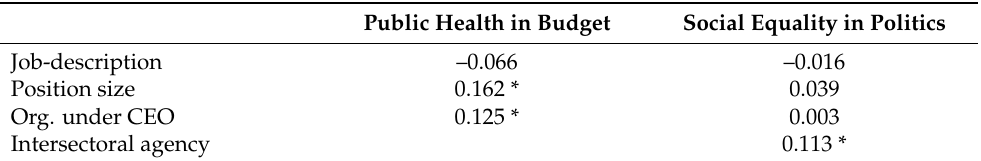
Table 7. Standardised indirect effects of organisational variables and intersectoral agency on public health in budget and social equality in